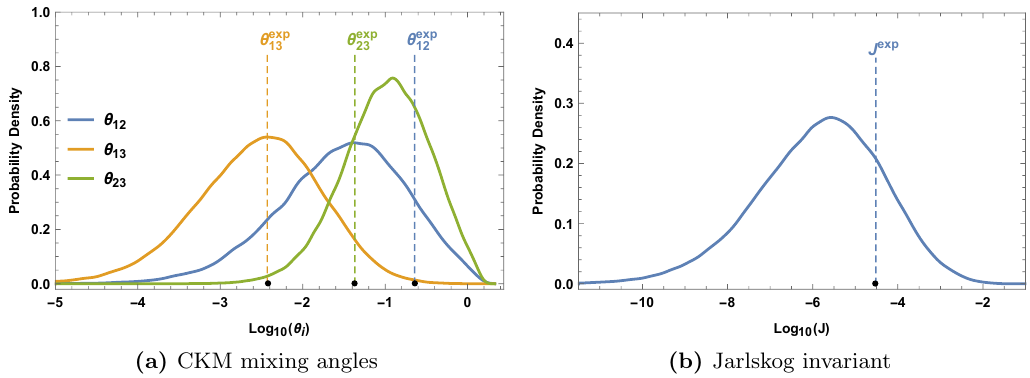
Figure 6. Quark mixing distributions for N q = 5, N u = 7, N d = 2, (cid:24) q = 1 : 8, (cid:24) u = 1 and (cid:24) d =